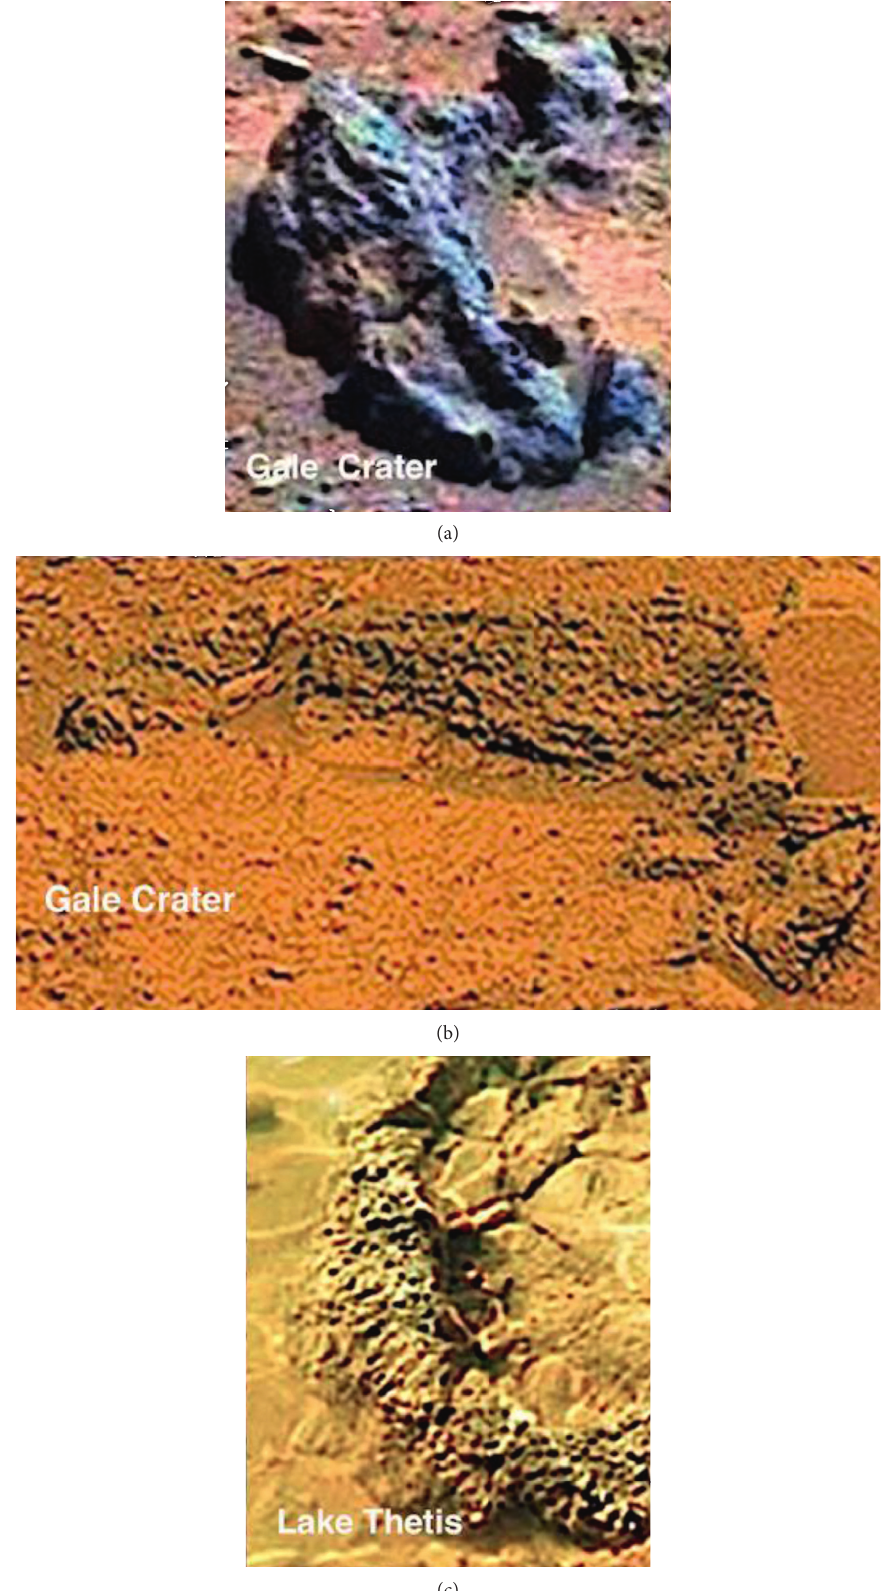
Figure 4: (a) Gale crater/sol 528 (close up of sol 122 (Figure 3). (b) Close up of sol 529. Note . Features resembling apertures, open cone-like structures, gas domes, and fenestrae. These gale crater specimens may be hundreds, thousands, or hundreds of thousands of years in age. Both appears to be fossilized and weathered. Contrast with (c) Lake Thetis living stromatolite photographed beneath the water and featuring numerous gas domes, apertures, and